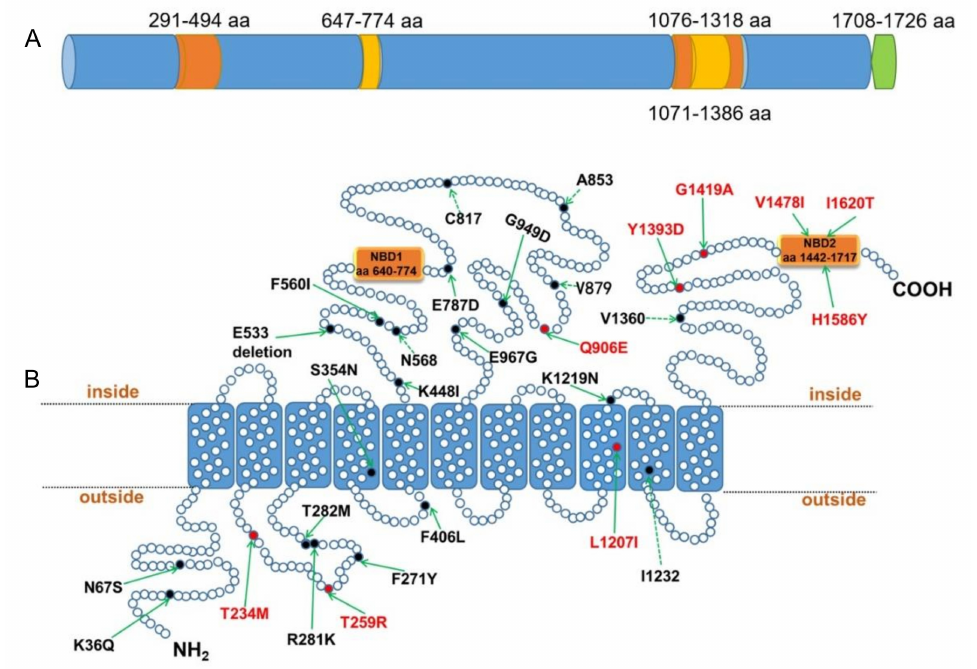
Figure 1. Predicted PvMRP1 primary protein structure and gene mutation. ( A ) Diagram of PvMRP1 primary protein structure, orange, yellow and green colors indicate conserved domain, Pfam domains, and GPI-anchor, respectively. ( B ) PvMRP1 shows the 11 predicted transmembrane helices. The positions of all the different mutations identified from the analysis of 94 geographically diverse isolates are indicated by filled circles, solid lines represent non-synonymous mutations, dotted lines represent synonymous mutations. The red font indicates that the mutation was reported previously